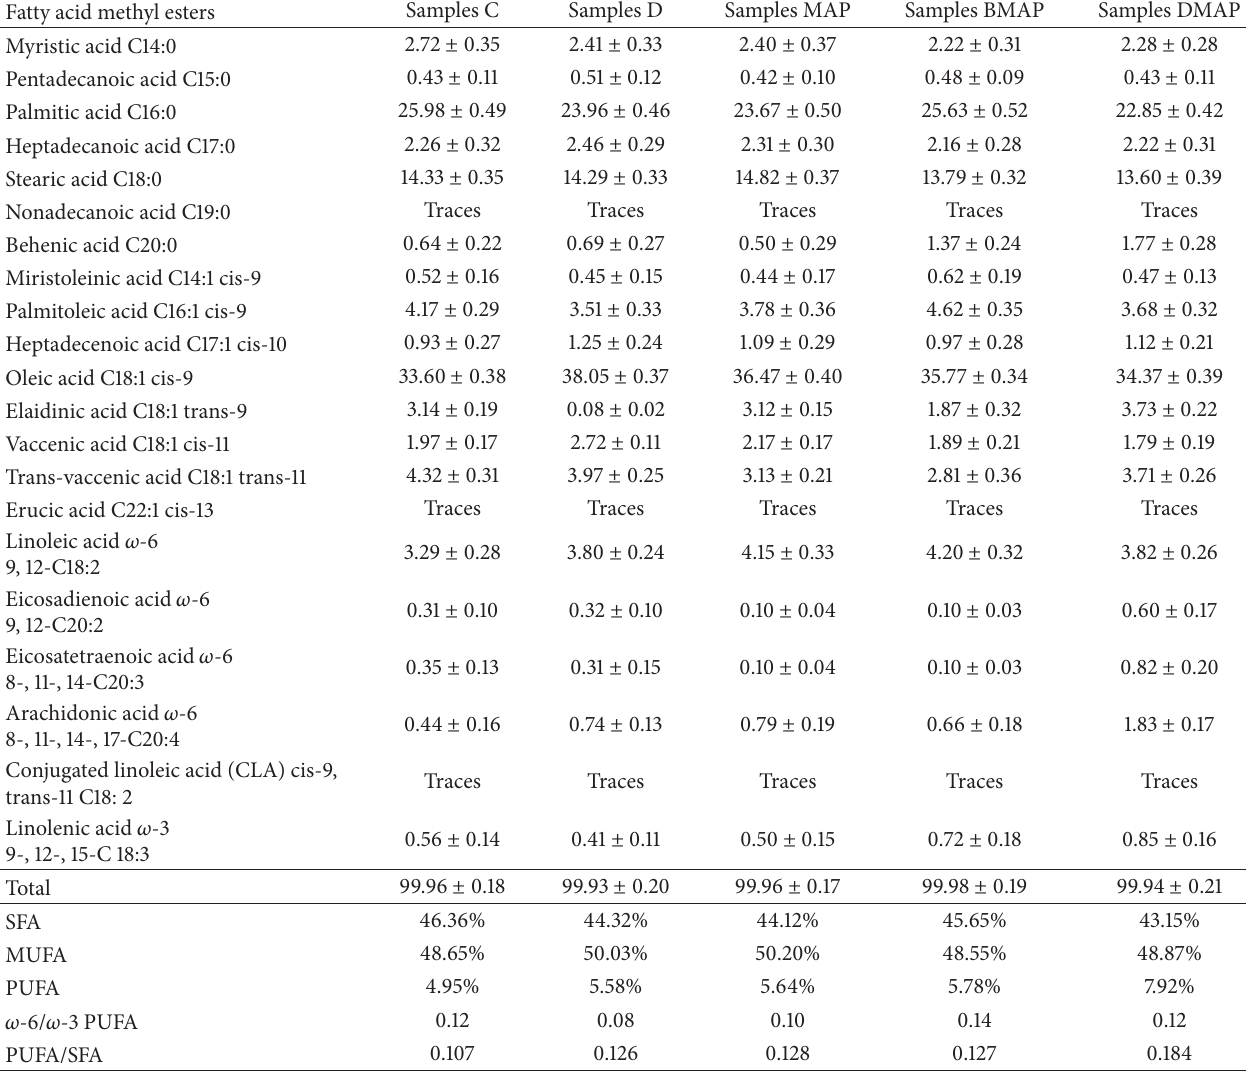
Table 2: The changes of FAME composition of veal samples during 8 DOS (15d post mortem ) at 0 ± 0.5 ∘